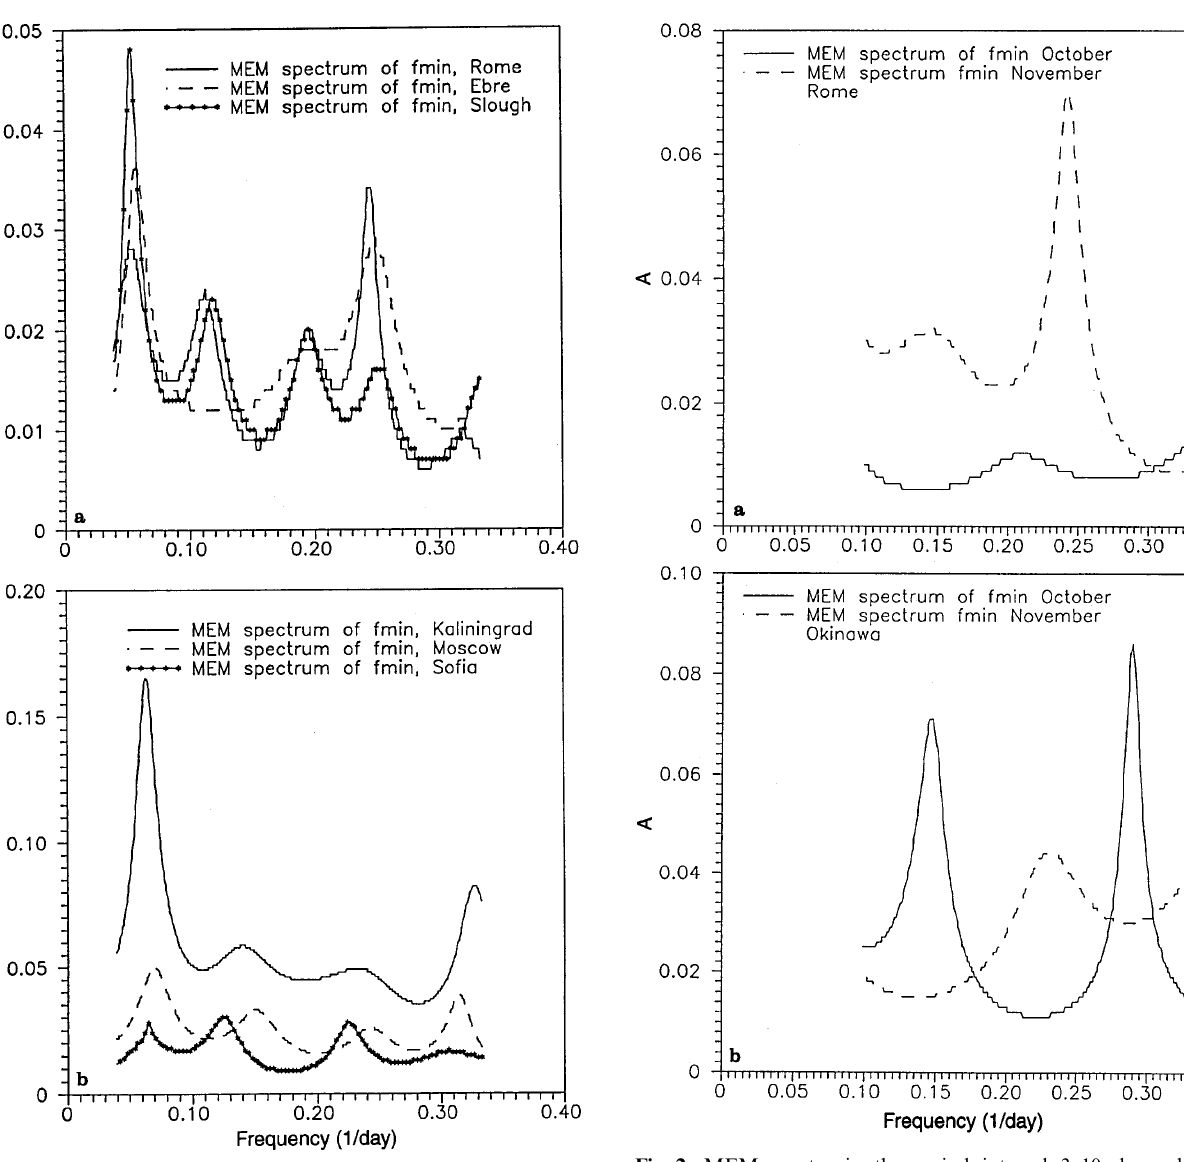
Fig. 1. MEM spectra in the period interval 3–25 days for a West European ionosonde stations: Slough ( solid line with asterisks ), Ebro ( solid line ), Rome ( dashed line ), and b East European stations: Kaliningrad ( solid line ), Sofia ( solid line with asterisks ), Moscow ( dashed line )